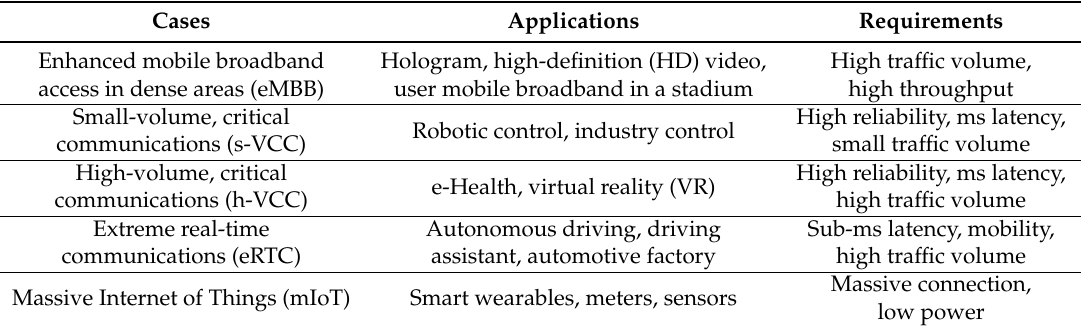
Table 1. Key 5G use cases and their